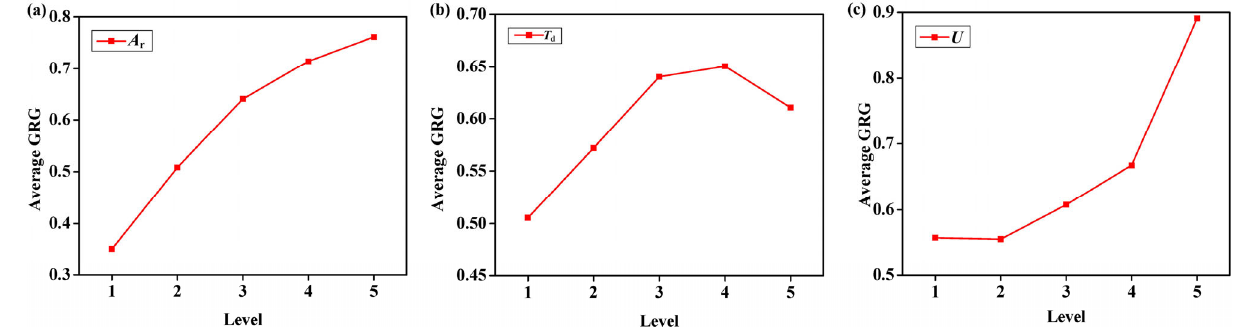
Fig. 12 Influence of triangle T1 bottom profile texture design variables: (a) aspect ratio, (b) texture density, and (c) flow speed on output responses.